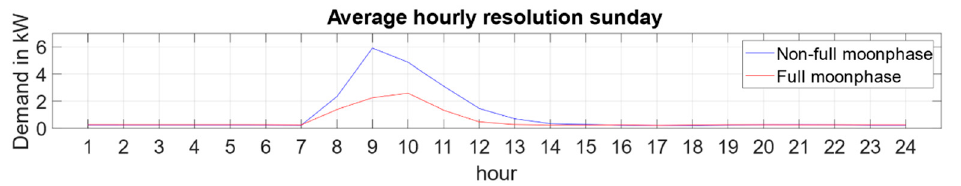
Figure 11. Average hourly electricity demand profile from the measurement during moon phases.